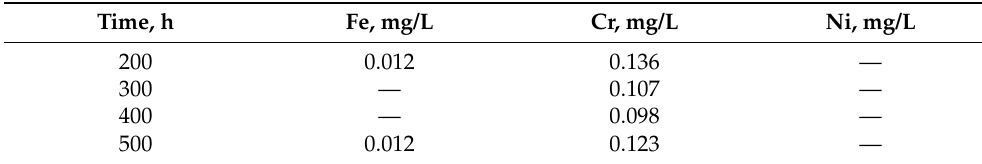
Table 3. The content of cations in the aqueous solution with different immersion times in this work (mg/L).